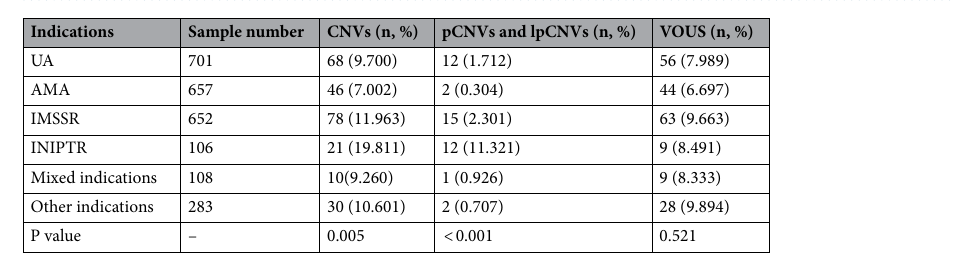
Table 5. Detection of CNVs in pregnancies with different indications. UA, ultrasound abnormalities; AMA, advanced maternal age; IMSSR, increased maternal serum screening risk; INIPTR, increased NIPT risk; lpCNVs, likely pathogenic CNVs. Other indications included previous fetus/child with genetic or phenotypic abnormalities, carriers of monogenic genetic diseases, medication during pregnancy, embryos stop developing, intellectual disability of pregnant